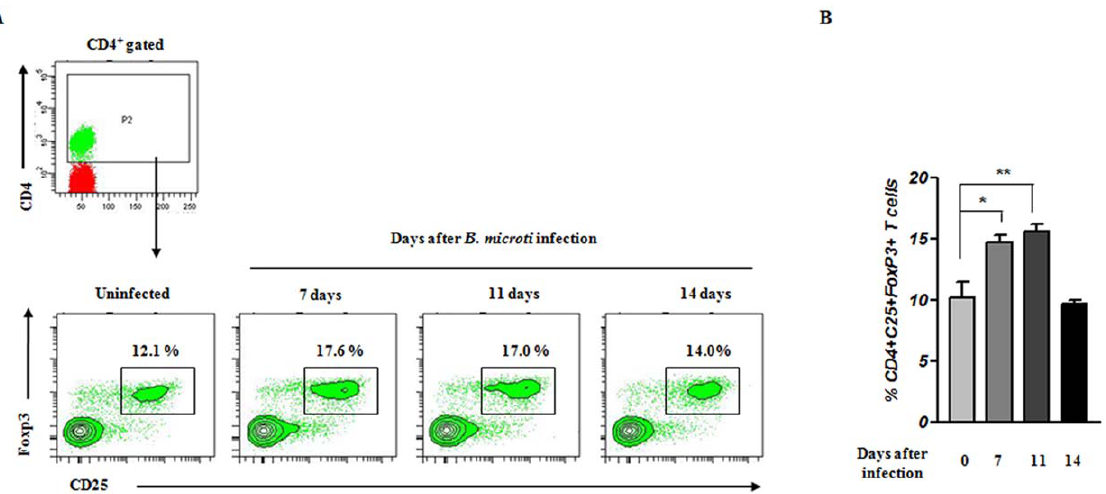
Figure 6. CD4 + CD25 + FoxP3 + T-cell frequencies increase during the course of B. microti infection. Splenocytes were stained with monoclonal antibodies against CD4 and CD25, permeablilized, stained intracellularly for FoxP3, and then analyzed by flow cytometry. (A) Representative data demonstrating the frequency of CD4 + CD25 + FoxP3 + T cells. The gating strategy used to identify CD4 + T cells is also depicted. (B) Bar graphs indicate the mean percentages 6 standard deviation of splenic CD4 + CD25 + FoxP3 + T cells in one representative experimental group consisting of five mice. * P , 0.01 and ** P , 0.001 compared with uninfected mice group. Results presented are from analysis of cells from individual mice and representative of five independent